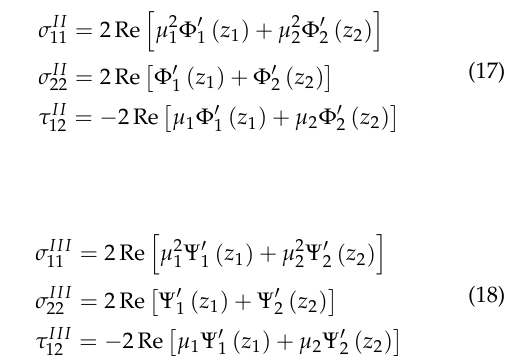
Fig. 2. Decomposition of the general problem into three elementary problems I, II and